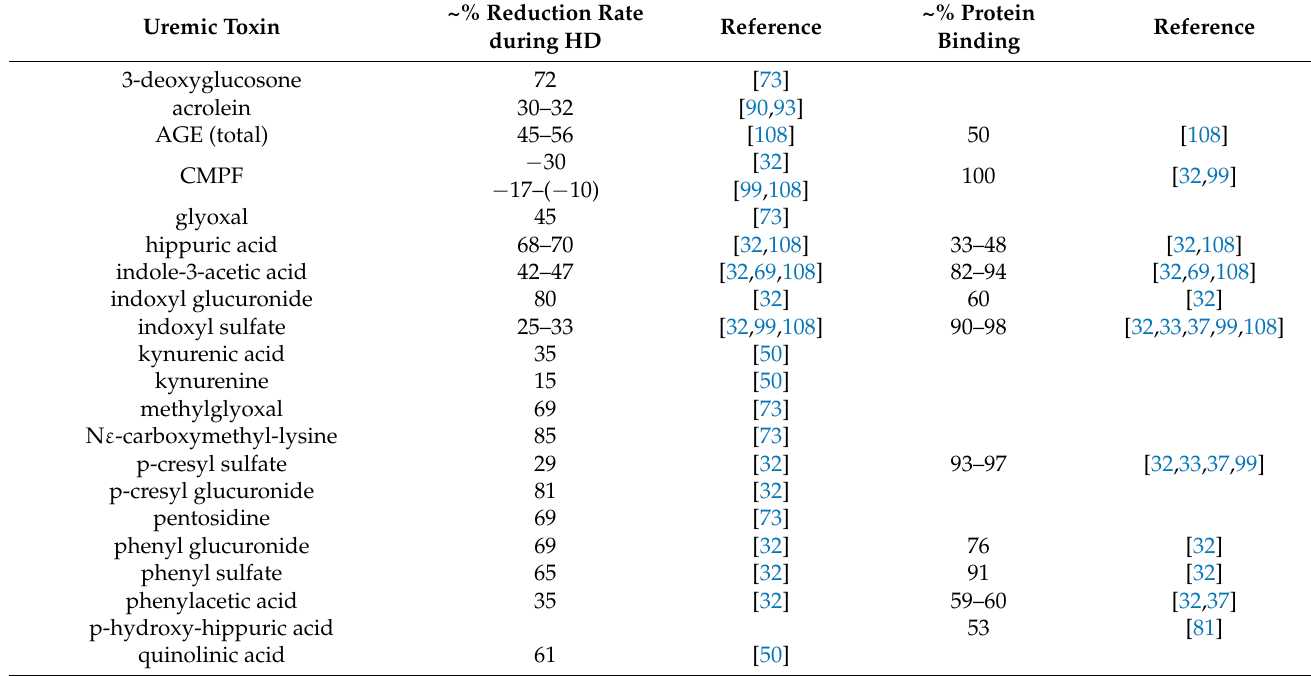
Table 1. The percentage of protein binding and reduction during hemodialysis for each described uremic toxin. ~% Reduction Uremic Toxin